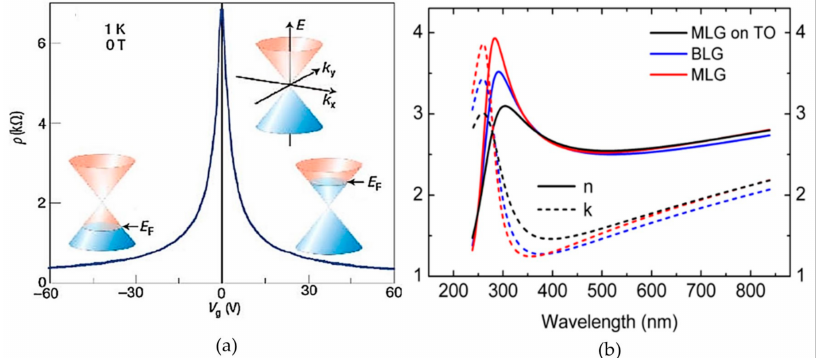
Figure 4. ( a ) Modulation of Fermi level with respect to gate biasing in single layer graphene. The inset shows a schematic of the band structure of pristine graphene with the presence of the Fermi level at the Dirac point (Reprinted from [31], with permission from Elsevier, 2010). ( b ) Refractive index and extinction coefficient for monolayer (red), bilayer (blue) and monolayer graphene with thermal oxide (black) (Republished with the permission of Royal Society of Chemistry, from [39]; permission conveyed through Copyright Clearance Center, Inc. (Danvers, MA, USA),